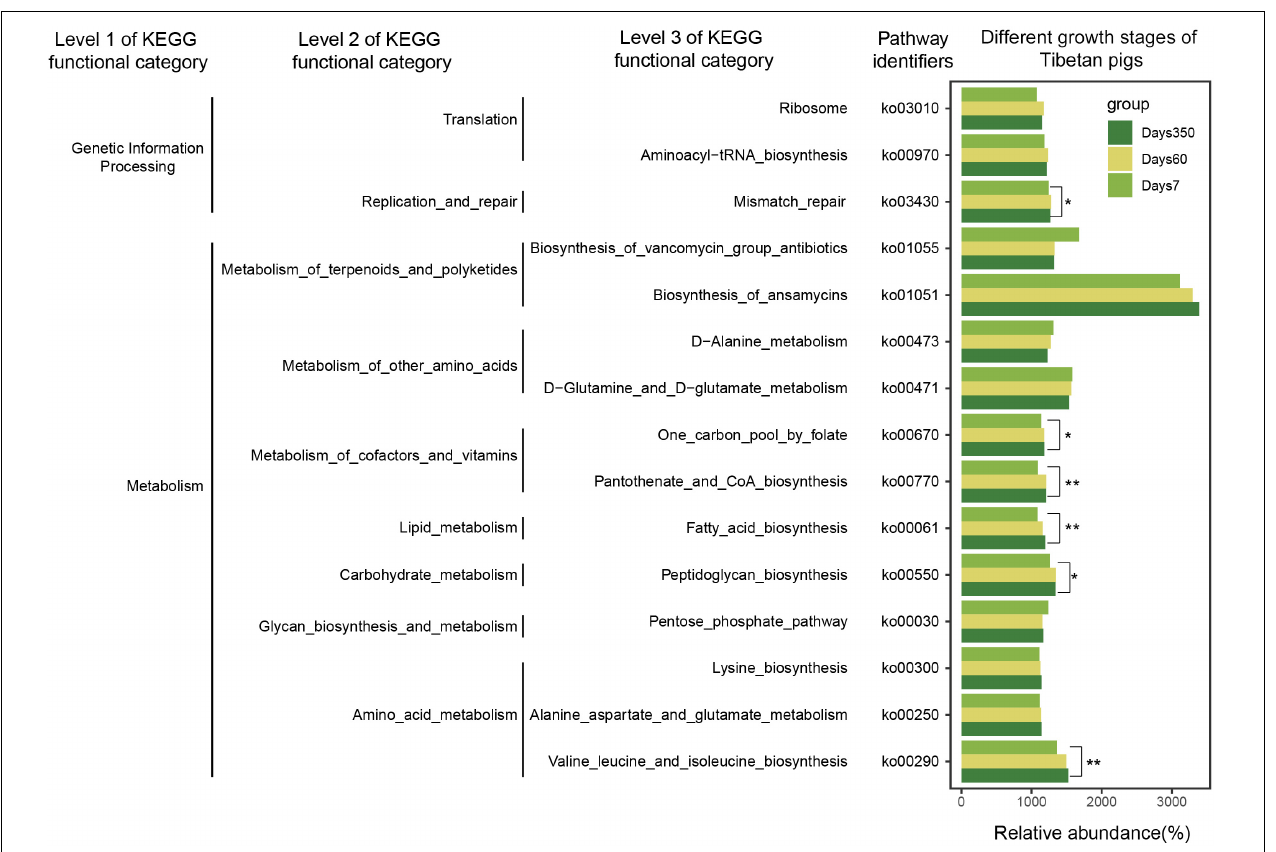
FIGURE 6 | Bacterial functional prediction of Tibetan pigs at three growth stages. The picture shows three levels of KEGG functional category. The gradient colors represent three growth stages. Significant differences were calculated by Kruskal–Wallis tests, * p < 0.05, ** p < 0.01.